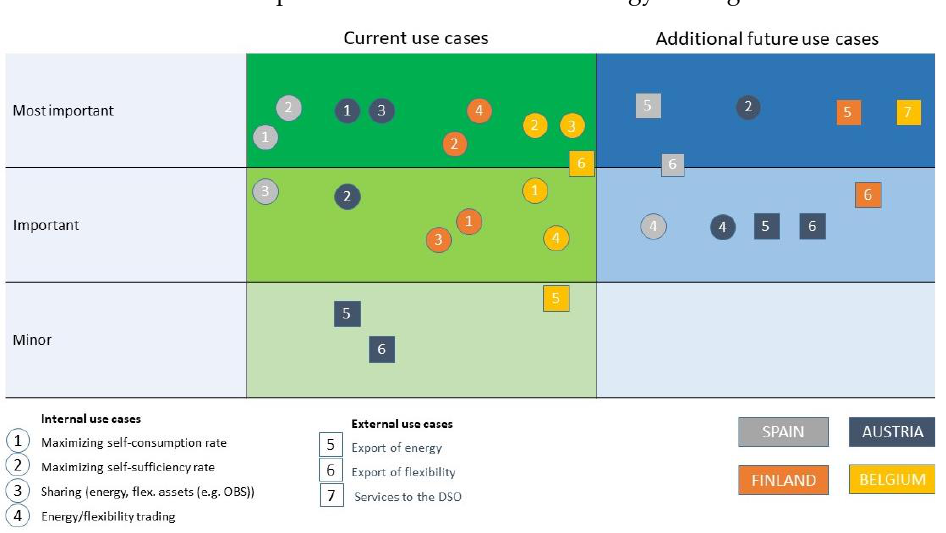
Figure 1. EXCESS PEB/PED use cases facilitated or enabled by the Clean Energy